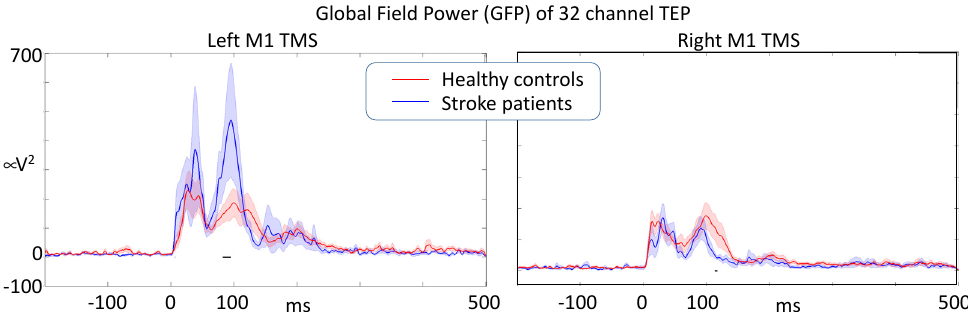
Figure 5. After artifact removal analysis, Global Field Power of the responses induced by single-pulse M1 TMS ( t = 0) describing the overall effective intracerebral connectivity of M1 projections. Stroke lesion was in the left hemisphere in all patients (black horizontal segments indicate a significant difference at p < 0.05).